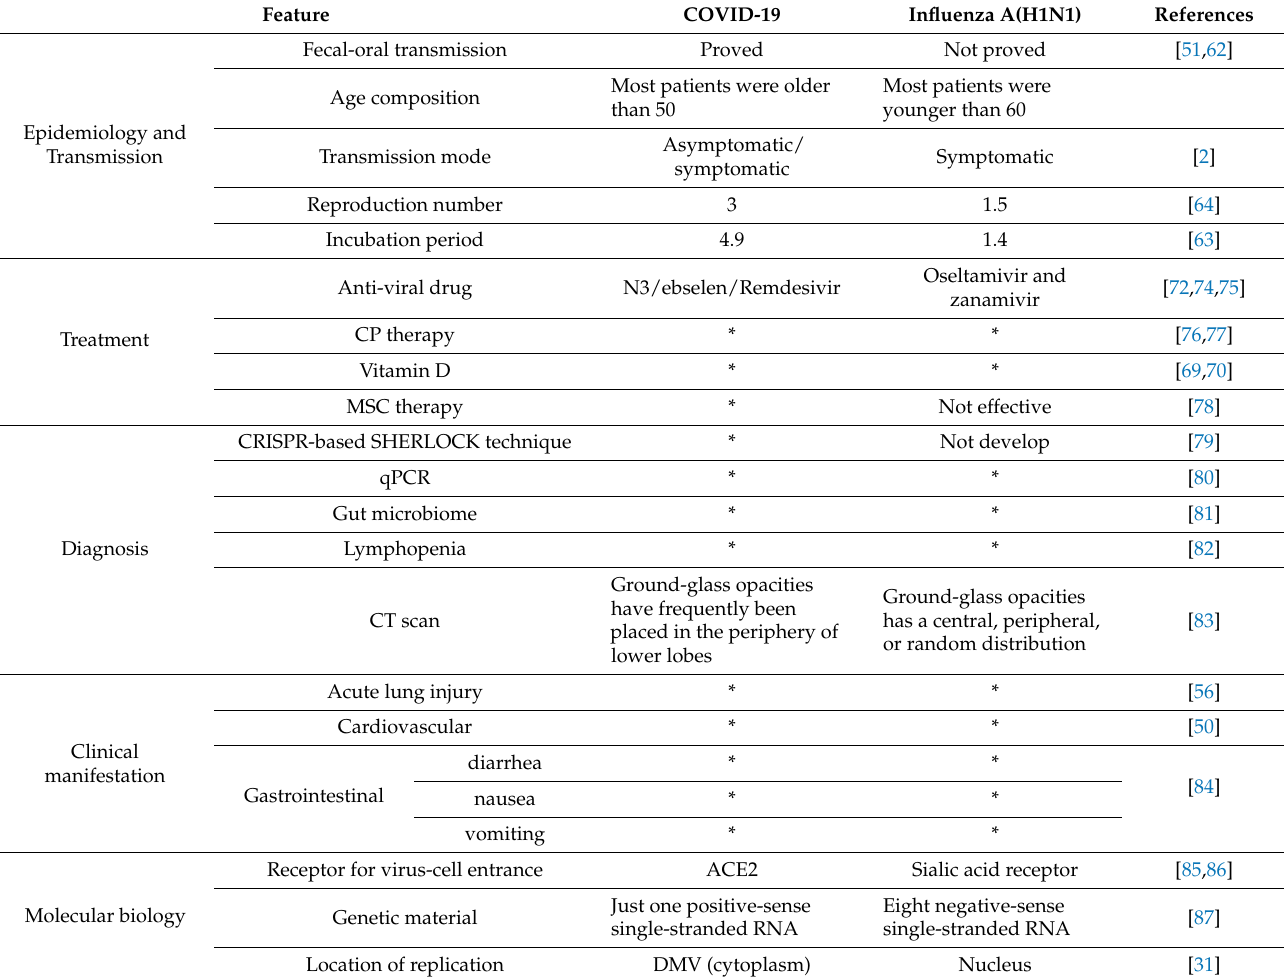
Table 2. A comparative analysis of the principal features in COVID-19 and Influenza